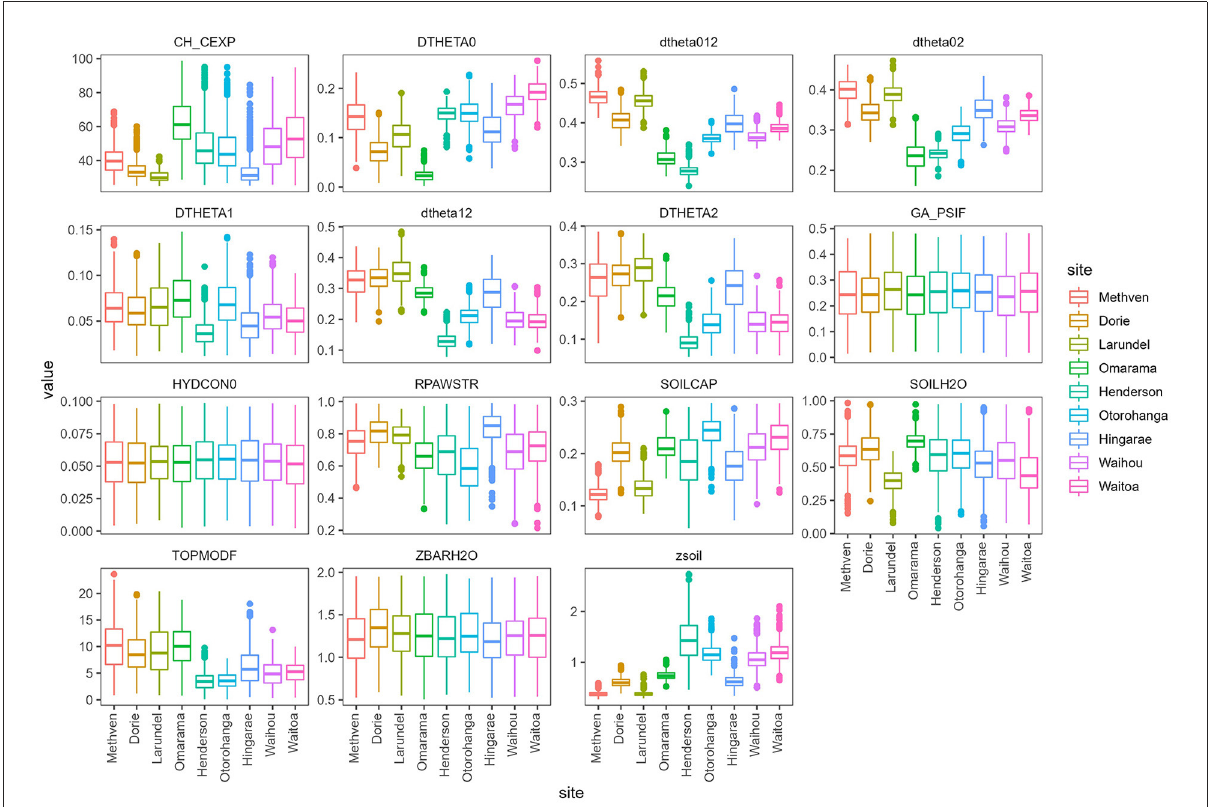
FIGURE11 Calibrated and upscaled parameters for all sites. Boxplots show the marginal posterior parameter distributions corresponding to Figure 8. Upscaled parameter values derived from the S-map-hydro soil database (as described in the text) are shown as black dots. The Y -axis units for each subplot are given in Table